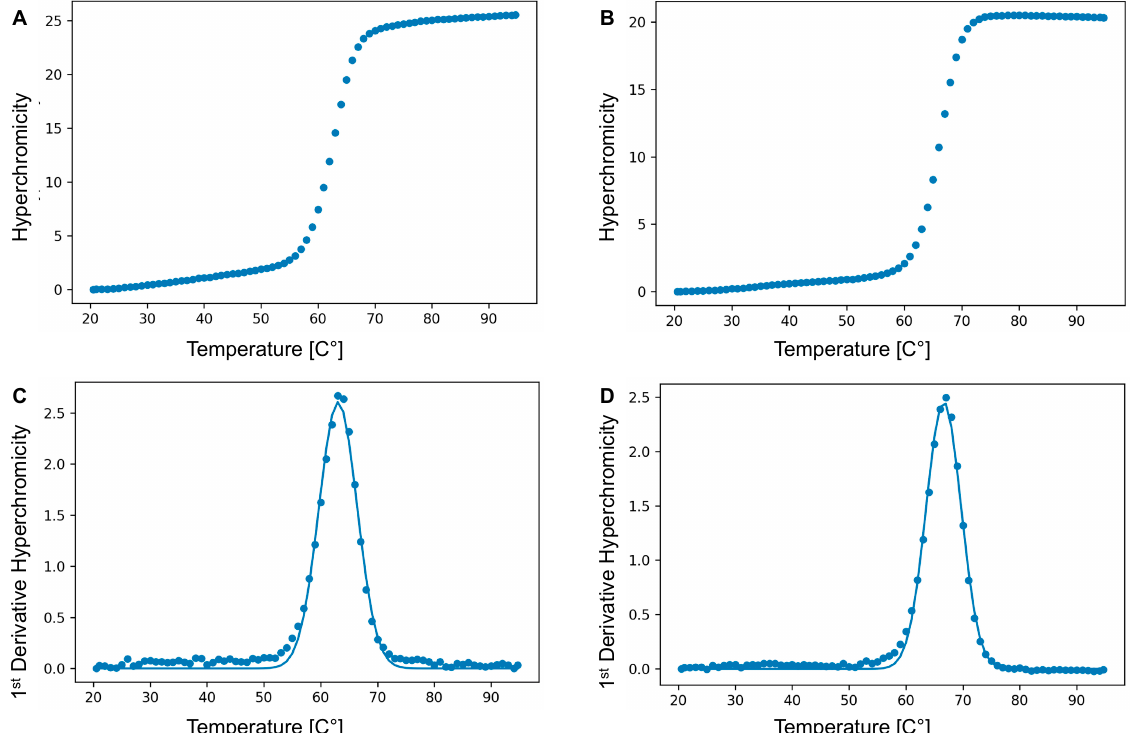
Figure 4. Illustrative UV melting curves ( λ = 260 nm) of: ( A ) the vancomycin-modified duplex and ( B ) the corresponding natural DNA duplex. The corresponding first derivatives are shown in panels ( C ) and ( D ), respectively. The total duplex concentration was 2 µM in 137 mM NaCl, 2.7 mM KCl, 4.3 mM Na 2 HPO 4 , 1.47 mM KH 2 PO 4 , and at pH 7.4.